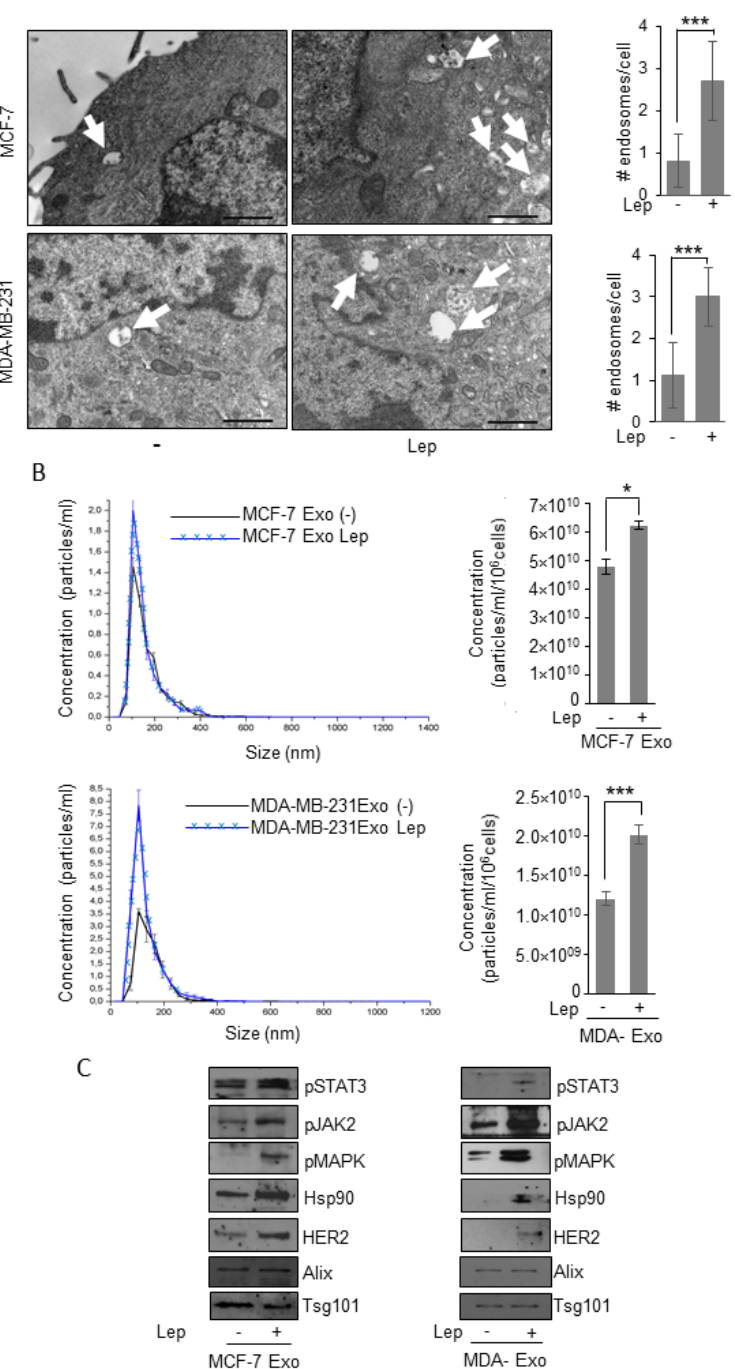
Figure 1. Leptin effects on exosome release in breast cancer cells. ( A ) Representative images of transmission electron microscopy (TEM) showing fields of multivesicular bodies (MVBs) in MCF-7 and MDA-MB-231 breast cancer cells treated with vehicle (-) or leptin (Lep, 500 ng/mL) for 48 h. Scale bar 1 μm. The histograms represent the mean ± S.D. of the MVB numbers in more than 15 fields per condition. ( B ) Representative size distribution profiles of exosomes (Exo), measured by nanoparticle tracking analysis, from conditioned media of MCF-7 and MDA-MB-231 breast cancer cells treated with vehicle (-) or Leptin (Lep, 500 ng/mL) for 48 h. The histograms represent the mean ± S.D. of exosome concentration (particles/mL/106 cells) of three different experiments. ( C ) Immunoblot analysis of pSTAT3, pJAK2, pMAPK, Hsp90, HER2, Alix, and Tsg101 protein expression in exosomal fraction from MCF-7 and MDA-MB-231 treated with vehicle (-) or with Lep for 48 h. * p < 0.05, *** p < 0.001.